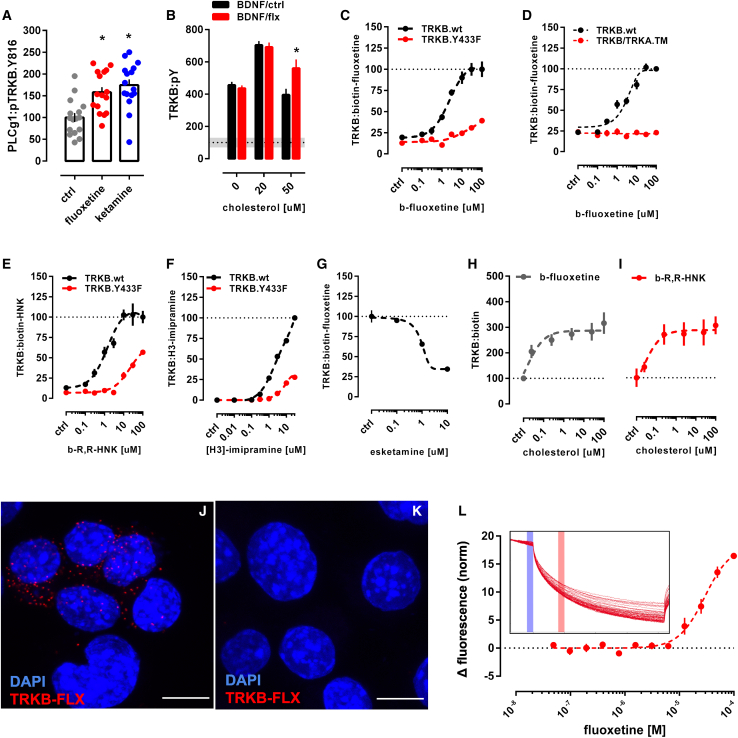
Antidepressants bind to TRKB transmembrane domain(A) Fluoxetine (10 μM/15 min) and ketamine (10 μM/15 min) increased pTRKB.Y816 in cortical neurons immunoprecipitated with anti-PLC-γ1 (F[2,45] = 11.03, p = 0.0001, n = 16/group).(B) Fluoxetine facilitates BDNF-induced activation of TRKB under high cholesterol concentrations (interaction: F[2,132] = 5.15, p = 0.0070, n = 12/group) in cultured cortical cells.(C and D) Biotinylated fluoxetine binds to TRKB in lysates of TRKB expressing HEK cells (interaction: F[7,153] = 16.18, p < 0.0001; n = 6–14), but not (C) to TRKB.Y433F mutant or (D) to TRKB carrying the TMD of TRKA (TRKB/TRKA.TM) (interaction: F[7,80] = 43.75, p < 0.0001, n = 6/group).(E and F) Binding of biotinylated R,R-HNK (interaction: F[7,160] = 14.91, p < 0.0001; n = 6–14) (E) and tritiated imipramine (interaction: F[7,16] = 106.1, p < 0.0001; n = 2) (F) to TRKB, but not to TRKB.Y433F. Data expressed mean ± SEM of percentage of binding at 100 μM for fluoxetine and R,R-HNK or at 30 μM for imipramine.(G) Esketamine displaces the interaction of biotinylated fluoxetine (1 μM) with TRKB (n = 8/group).(H and I) Cholesterol facilitates the interaction of (H) biotinylated fluoxetine (F[5,30] = 7.198, p = 0.0002, n = 6/group)and (I) R,R-HNK (F[5,30] = 4.592, p = 0.0031, n = 6/group) with TRKB.(J) In situ PLA demonstrates close proximity between biotinylated fluoxetine and TRKB on TRKB-expressing N2A cells (red dots).(K) No PLA signal is seen in cells not expressing TRKB. Blue, DAPI; scale bar, 10 μm.(L) MST demonstrated direct interaction between fluoxetine and GFP-tagged TRKB (15 min) in lysates from GFP-TRKB expressing HEK293T cells (n = 4/group). Experimental traces depicted in the inset, vertical bars: blue, fluorescence cold; red, fluorescence hot.See also Figures S2, S4, and S5.